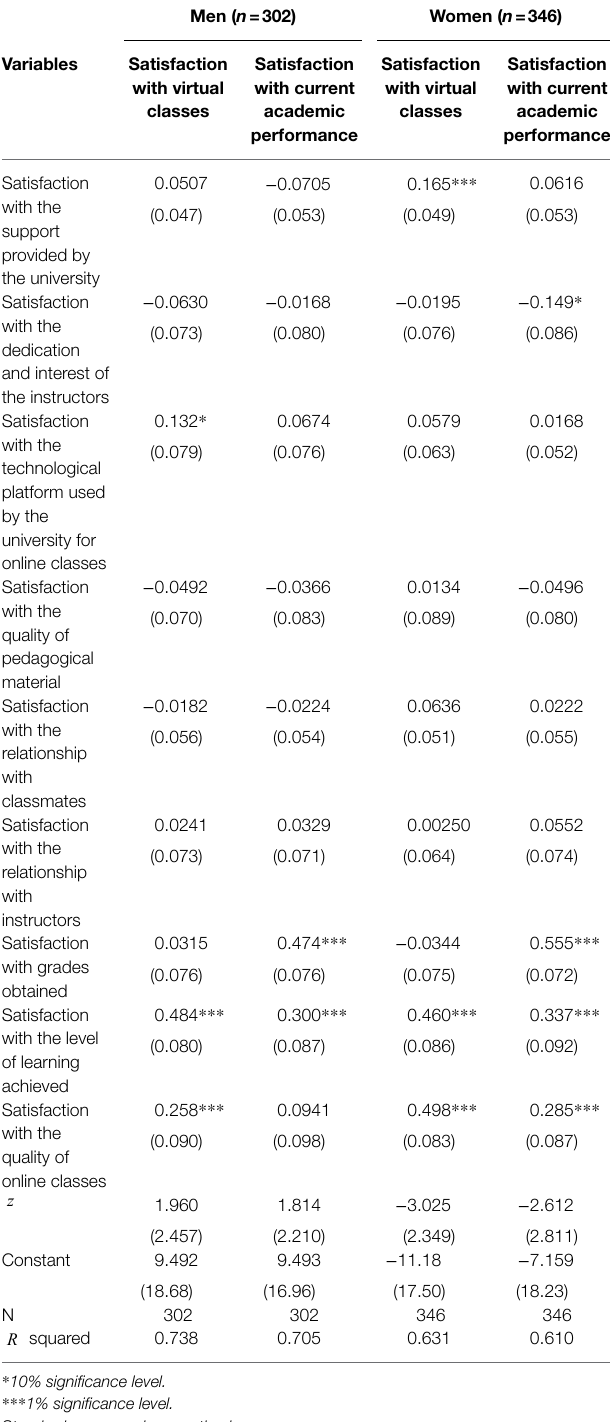
TABLE 4 | Two-layer method: estimates separated by